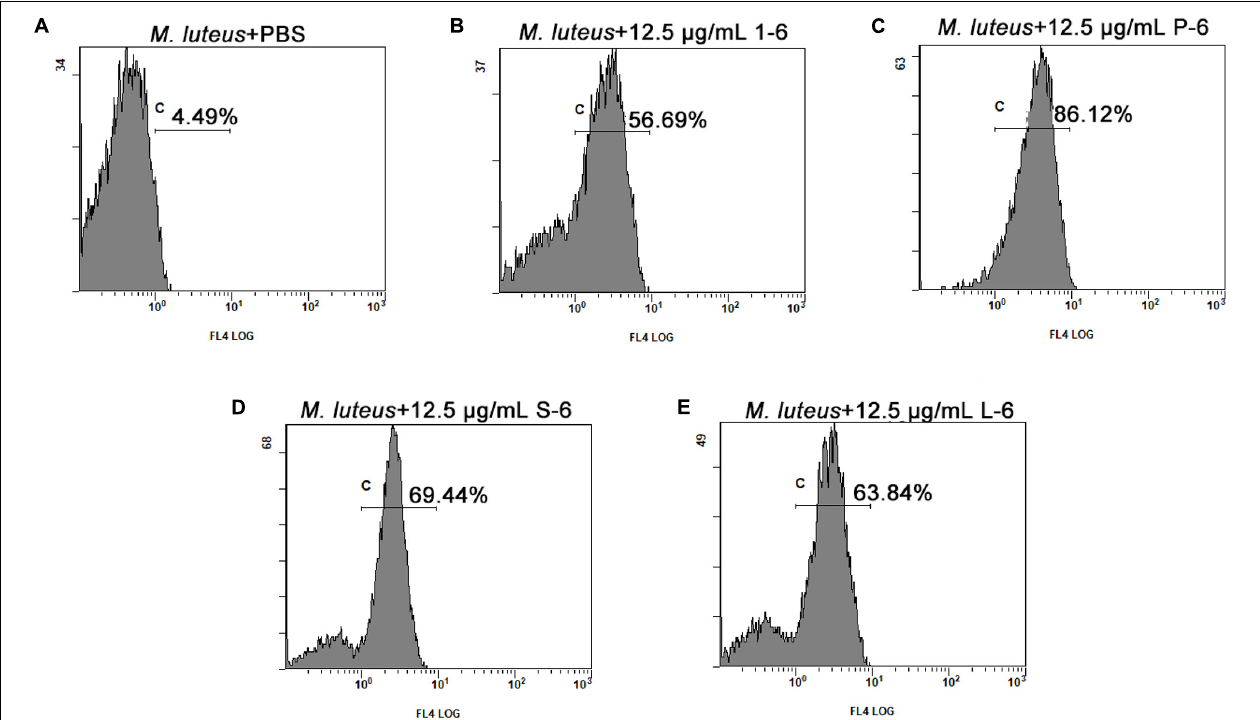
FIGURE 8 | Membrane permeation of M. luteus . The effects of 12.5 µ g/ml of 1–6, P-6, S-6, and L-6 on the membrane integrity of M. luteus cells were analyzed using flow cytometry. The proportion of permeabilized cells is shown near c. (A) The effects of 12.5 µ g/ml of PBS on the membrane integrity of M. luteus cells were analyzed using flow cytometry. (B) The effects of 12.5 µ g/ml of 1–6 on the membrane integrity of M. luteus cells were analyzed using flow cytometry. (C) The effects of 12.5 µ g/ml of P-6 on the membrane integrity of M. luteus cells were analyzed using flow cytometry. (D) The effects of 12.5 µ g/ml of S-6 on the membrane integrity of M. luteus cells were analyzed using flow cytometry. (E) The effects of 12.5 µ g/ml of L-6 on the membrane integrity of M. luteus cells were analyzed using flow